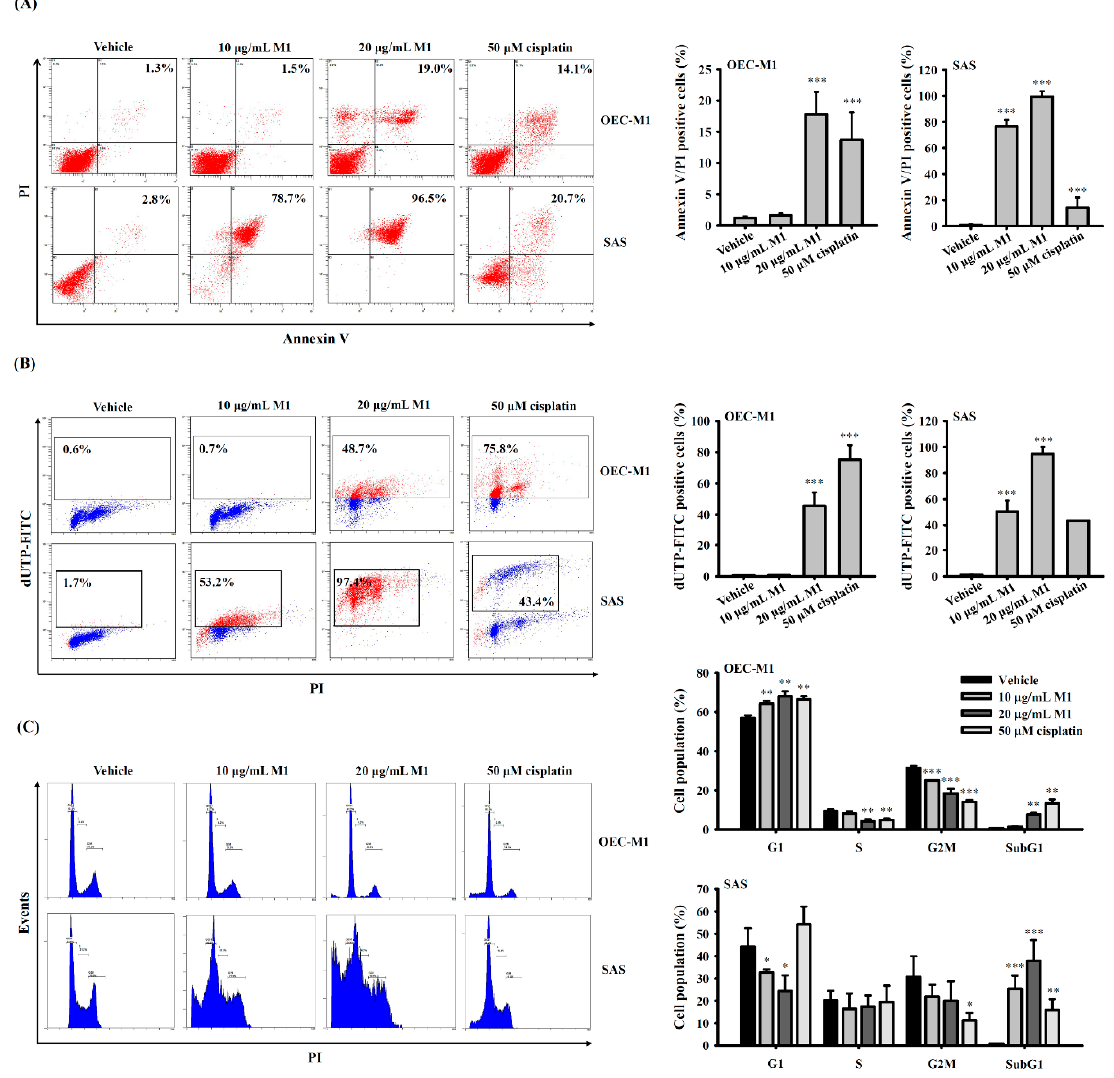
Figure 3. Ginsenoside M1 induced apoptosis in human oral cancer cells. OEC-M1 cells and SAS cells were incubated for 24 h with ginsenoside M1, cisplatin, or vehicle. Apoptosis levels were analyzed by Annexin V/PI double staining ( A ). DNA breaks levels were analyzed by TUNEL assay ( B ). Cell cycle distribution was determined by PI staining ( C ). The data were expressed as mean ± SD; n = 3. *, **, and *** indicate a significant difference at the level of p < 0.05, p < 0.01, and p < 0.001, respectively, compared to vehicle-control cells. (One-way ANOVA with Dunnett’s multiple comparisons test).